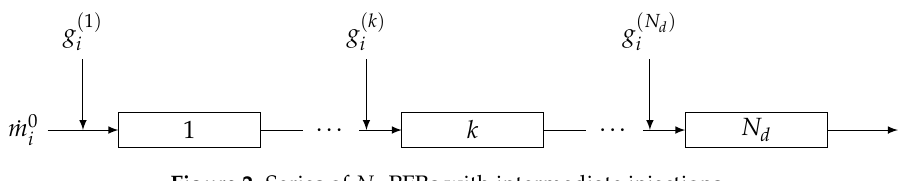
Figure 2. Series of N d PFRs with intermediate